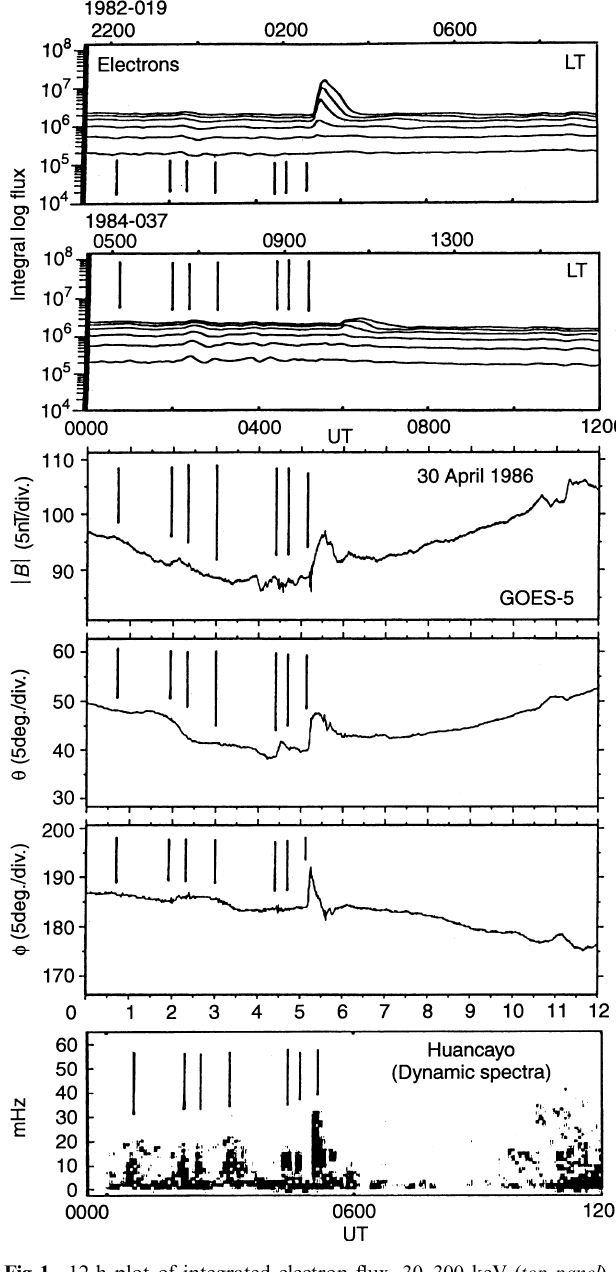
Fig 1. 12-h plot of integrated electron flux, 30–300 keV ( top panel ), fluxgate magnetometer ( middle panel ) data from geosynchronous satellites 1982-019, 1984-037 and GOES 5, and dynamic spectra of the ground magnetometer data ( bottom panel ) at Huancayofor 30 April 1986. The local time of the satellites 1982-019 and 1984-037 is shown in the upper part of each trace. GOES 5 and the ground station, Huancayo, are located in the same meridian, local time is UT (cid:255) 5. B , (cid:104) , and (cid:47) are field line magnitude, field line inclination and azimuth, in dipole coordinates (see text). The Pi 2 events are shown by vertical bars in